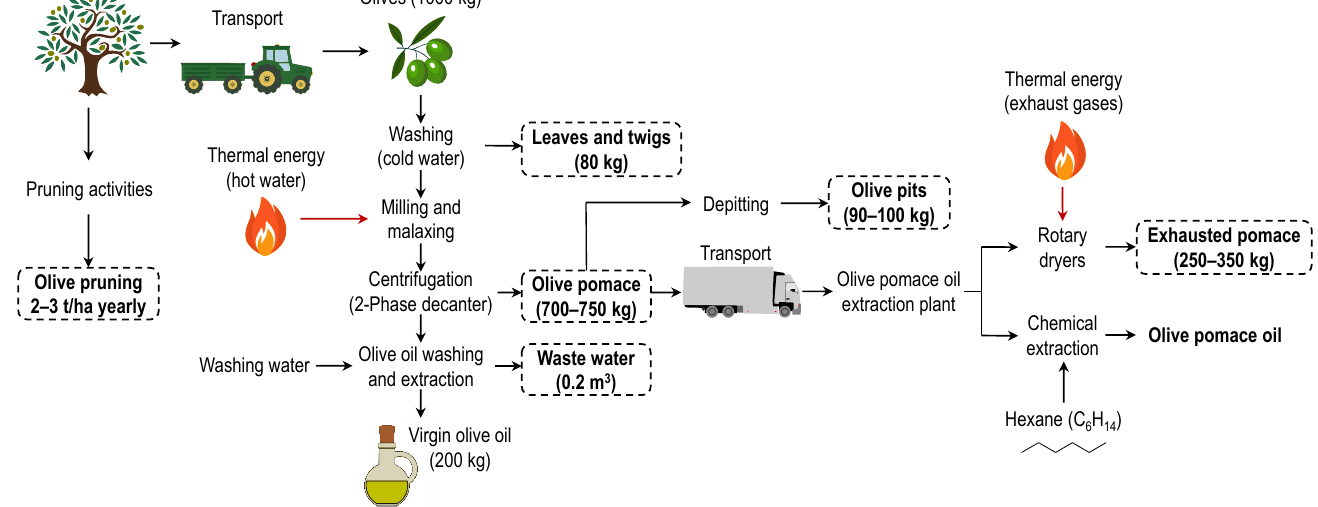
Figure 1. Products and by-products of the olive oil industry supply chain (two-phase extraction process).